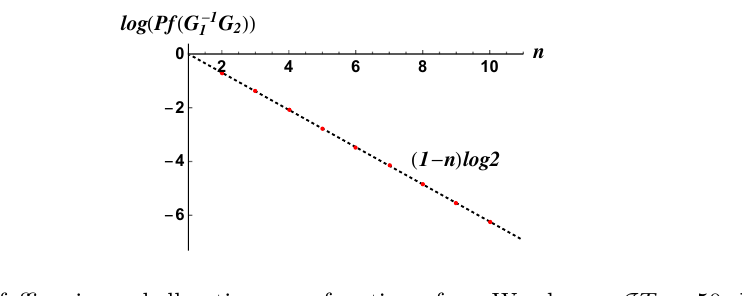
Figure 9 . The Pfa(cid:14)an in onshell action as a function of n . We choose J T = 50, V = J = 0 : 2, q = 4. The number of discretization is M =